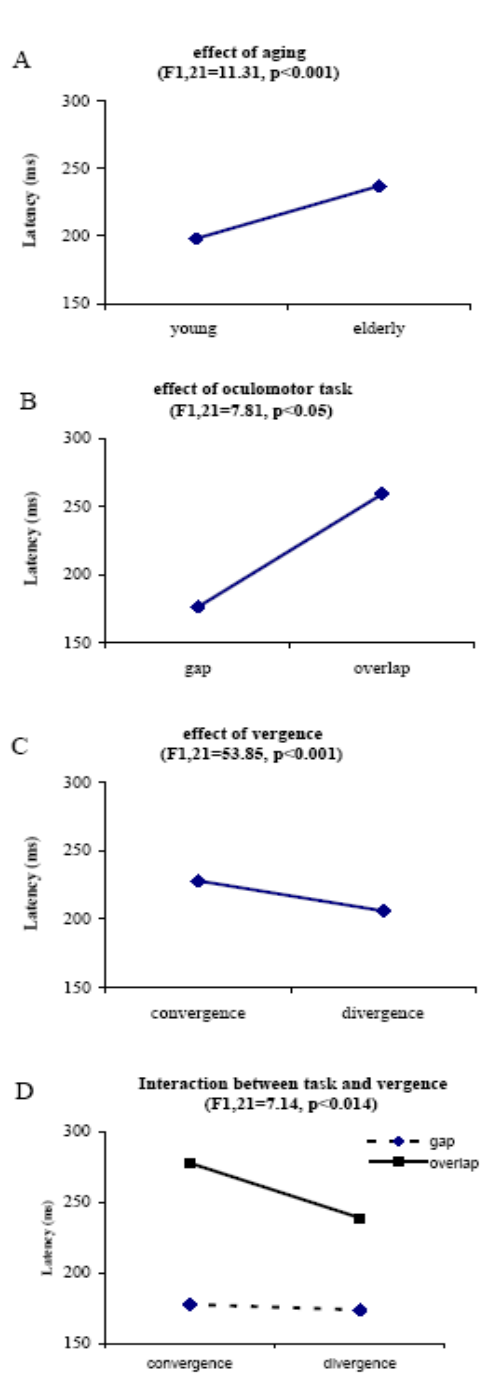
Figure 4. Main effects of the age (A), of the gap (B), of the vergence (C), and interaction between task and vergence (D). Vertical lines indicate the standard errors. Asterisks indicate statistically significant